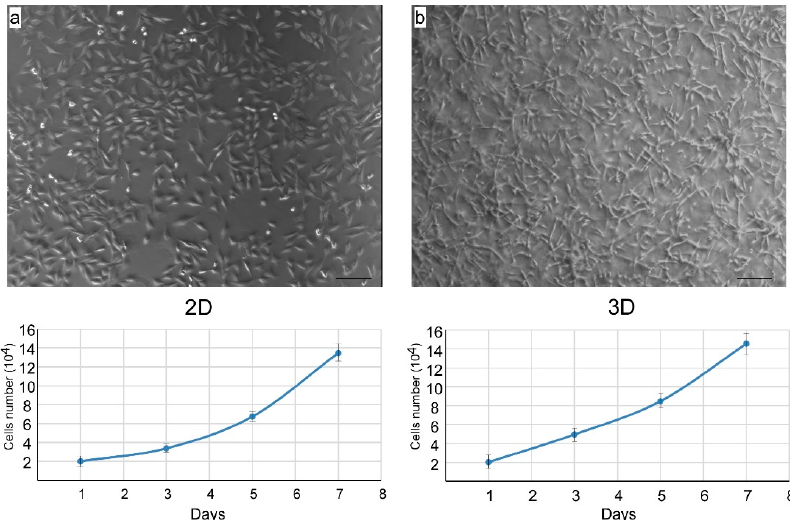
Figure 4. Phase contrast images and growth kinetic curves of chondrocyte isolated with col H plus TML and cultured in 2D ( a ) and 3D ( b ) conditions.